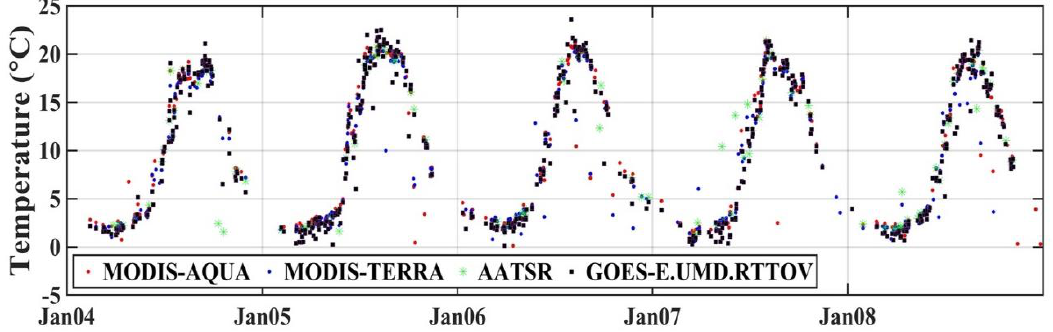
Figure 1. Instantaneous LST as derived from the JPL archive for MODIS/Terra, MODIS/Aqua, AATSR, and from GOES-E UMD (matched in both time (±15 min) and location (0.05° × 0.05° box)) at JPL500 (44.757° N, 82.34° W). Red dot : MODIS/Aqua; Blue dot: MODIS/Terra; Green plus : AATSR; Black square : UMD GOES-E LST. Period covered is 2004 – 2008.